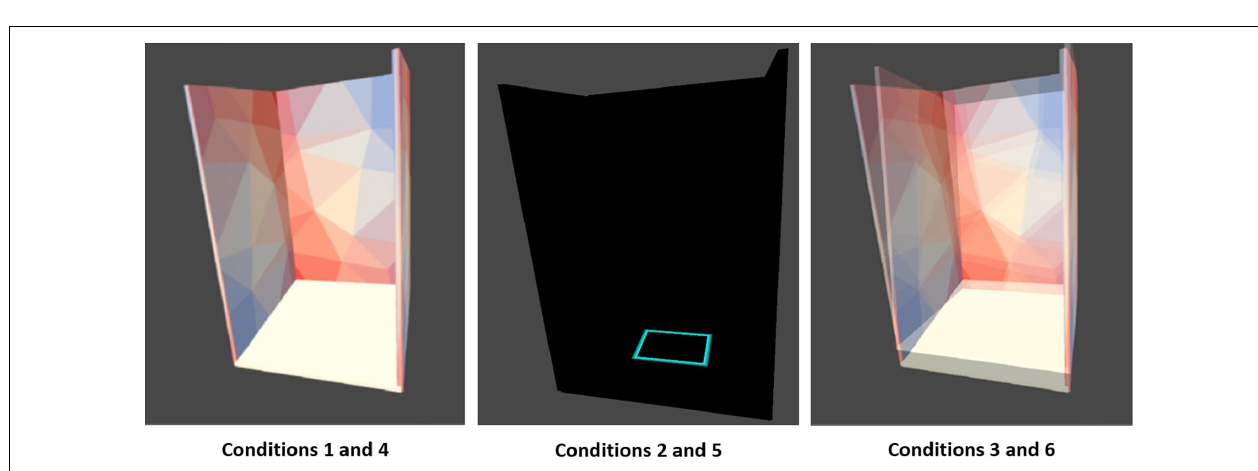
FIGURE 2 | Six VR-ComBAT conditions. (1) stable surface with fixed virtual reality (VR) surroundings; (2) stable surface with blacked out VR surroundings; (3) stable surface with VR visual conflict; (4) unstable surface with fixed VR surroundings; (5) unstable surface with blacked out VR surroundings; and (6) unstable surface with VR visual